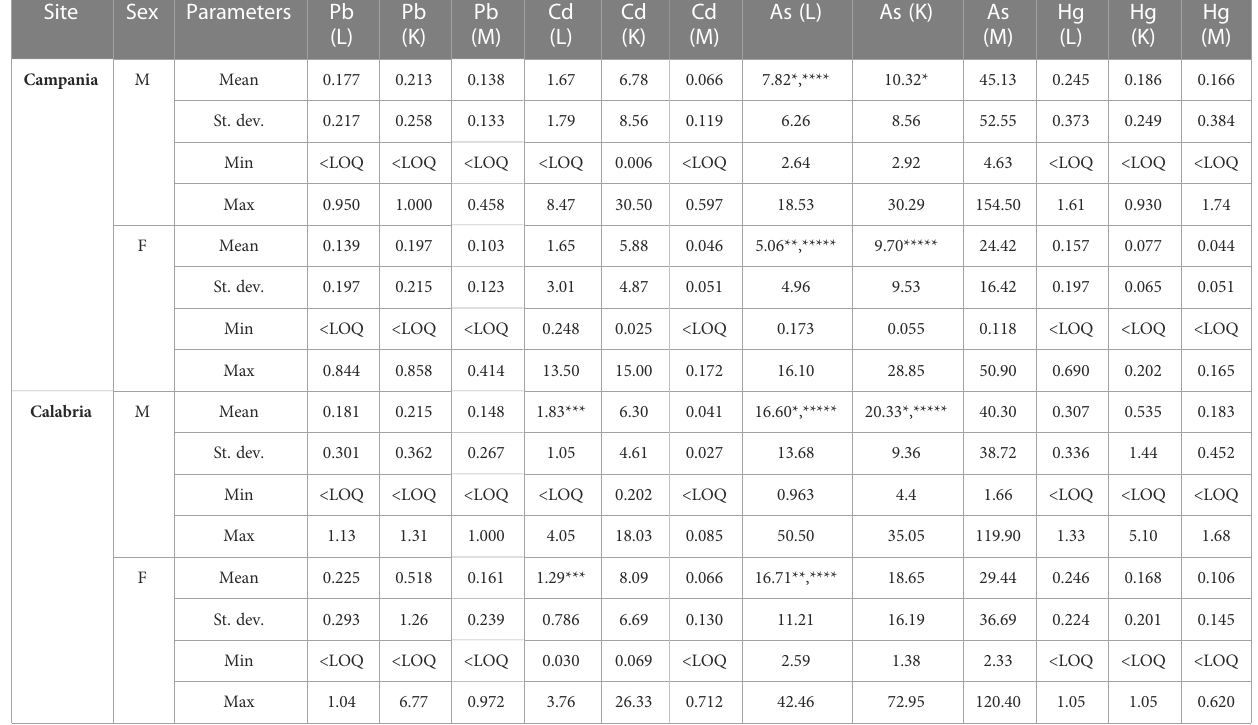
*p-values of the comparison between the As (L) and As (K) values of the analysed male turtles from the Campania vs. Calabria regions: p < 0.05 and p < 0.01, respectively; **p-value of the comparison between the As (L) values of the analysed female turtles from the Campania vs. Calabria regions: p < 0.01; ***p-value of the comparison between the Cd (L) values of the analysed male vs. female turtles from the Calabria region: p =0.06; ****p-value of the comparison between the As (L) values ofthe analysed male turtles from the Campania region vs. femaleturtles from the Calabria region: p < 0.05; *****p-value of the comparison between the As (L) and As (K) values of the analysed male turtles from the Calabria region vs. female turtles from the Campania region: p <